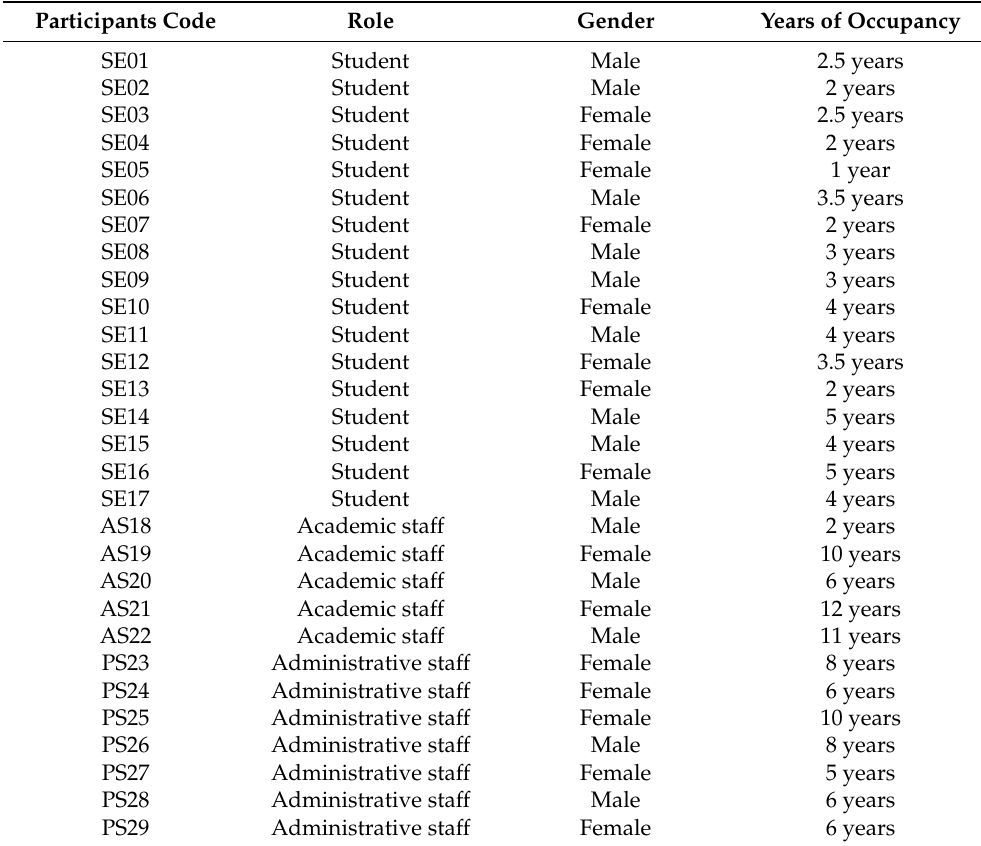
Table 3. Demographic of